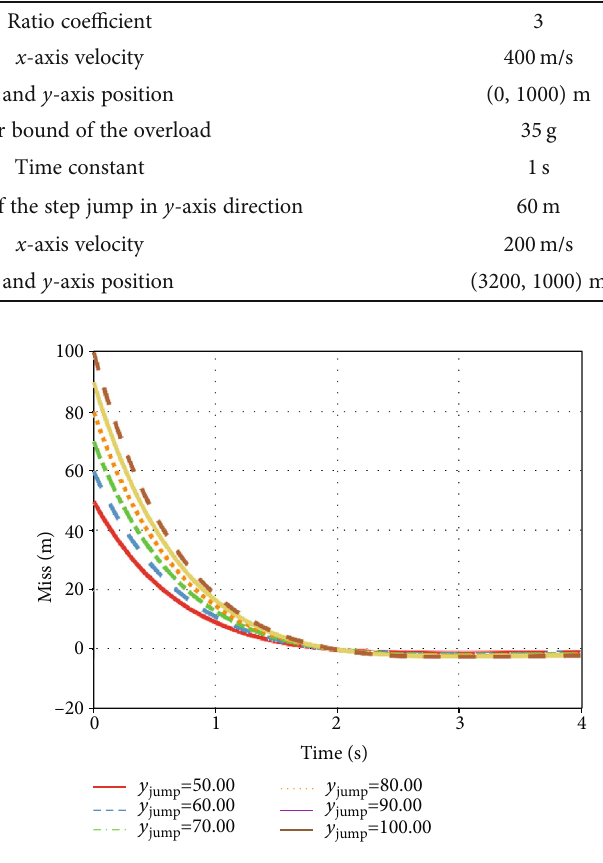
Figure 15: In fl uence of the jump amplitude on the miss